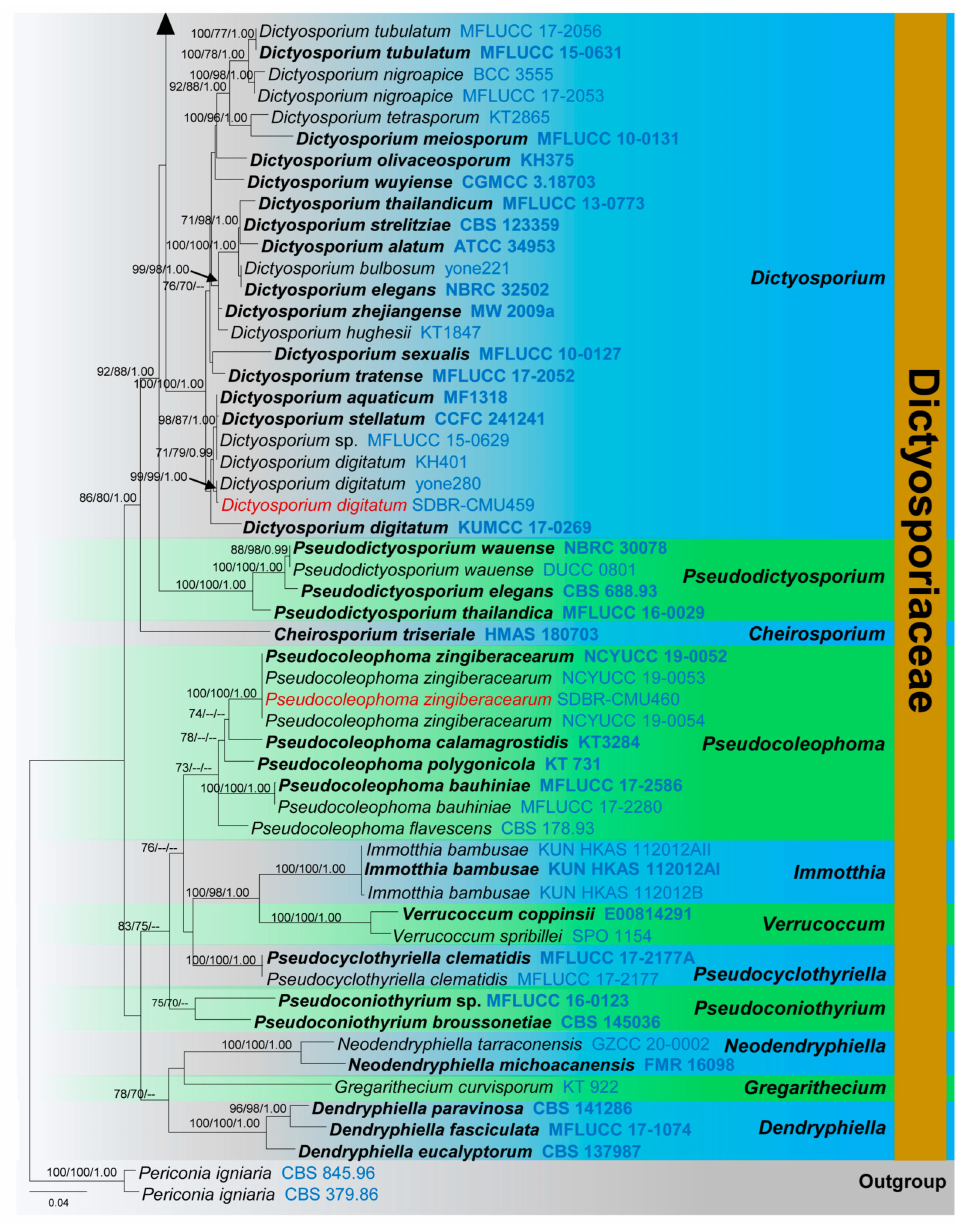
Figure 1. The phylogram generated from maximum likelihood analysis is based on combined LSU, ITS, and tef1- α sequence data. The tree is rooted with Periconia igniaria (CBS 379.86 and CBS 845.96). The new isolates are in red, and ex-type strains are bold. All the strain numbers are in blue. Bootstrap support values ≥ 70% from the maximum likelihood (ML) and maximum parsimony (MP) and Bayesian posterior probabilities (BYPP) values ≥ 0.90 are given above the nodes, respectively. Multigene phylogeny showed strong statistically supportive values within the clades (Figure 1). Bootstrap support values for ML, MP higher than 70%, and BYPP greater than 0.90 are given above each branch, respectively (Figure 1). All the analyses (ML, MP, and BYPP) generated similar findings and concurred with previous studies based on multi-gene